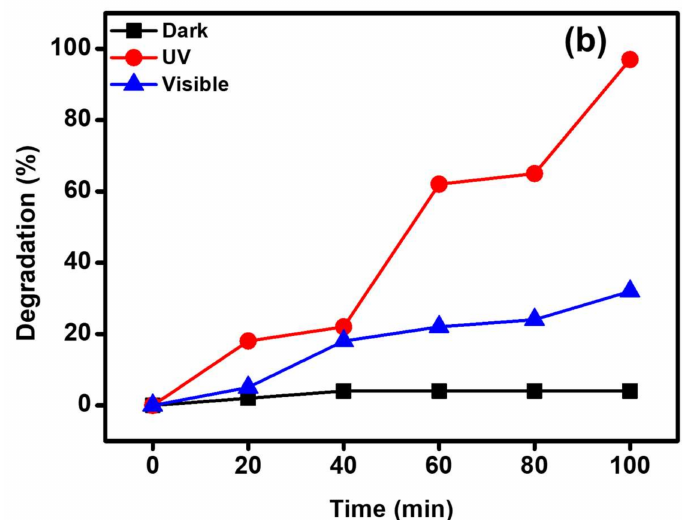
Figure 7. Impact of light source on ( a ) MB and ( b ) MY photodegradation employing the synthesized ZnO